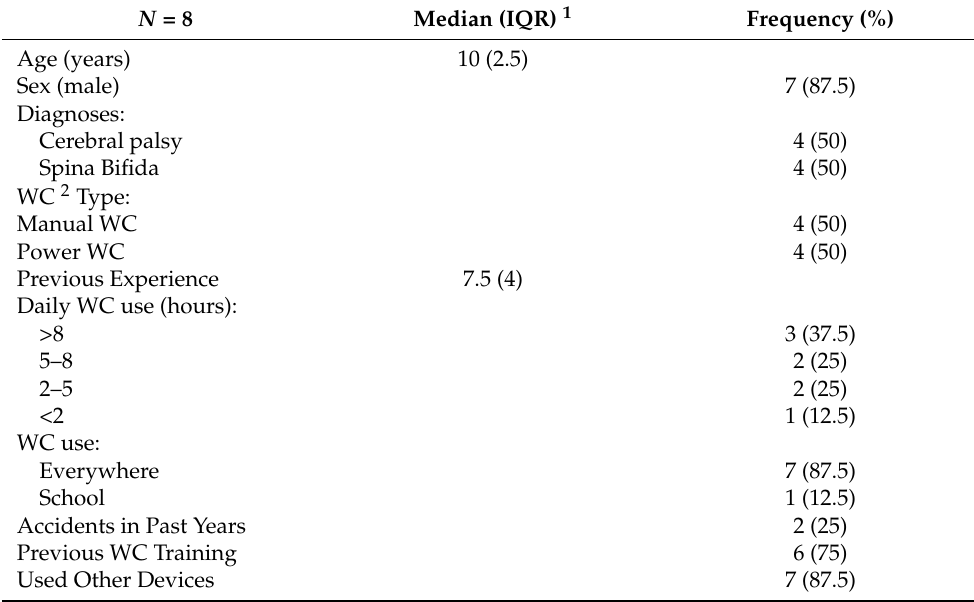
Table 1. Sociodemographic and wheelchair use information of participants.